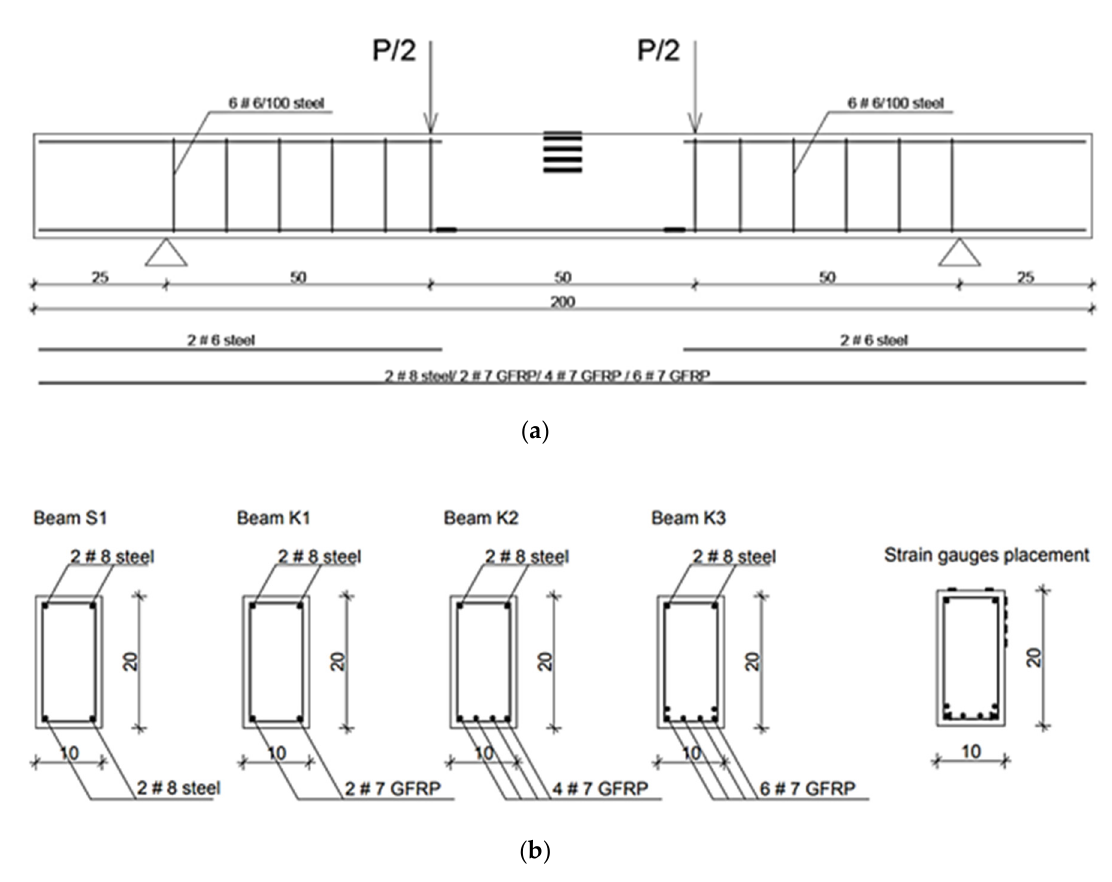
Figure 1. (a) Beam longitudal section; ( b) The cross-section of studied beams. Figure 1. ( a ) Beam longitudal section; ( b ) The cross-section of studied